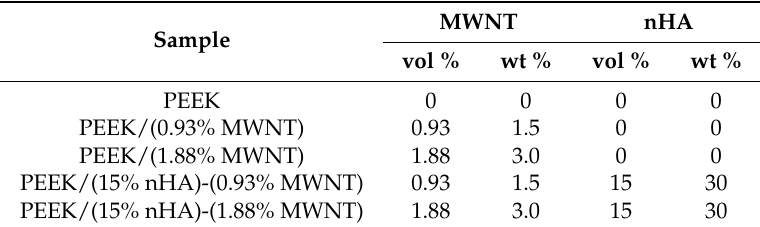
Table 1. The compositions of binary PEEK/MWNT and ternary PEEK/(15 vol % nHA)-MWNT